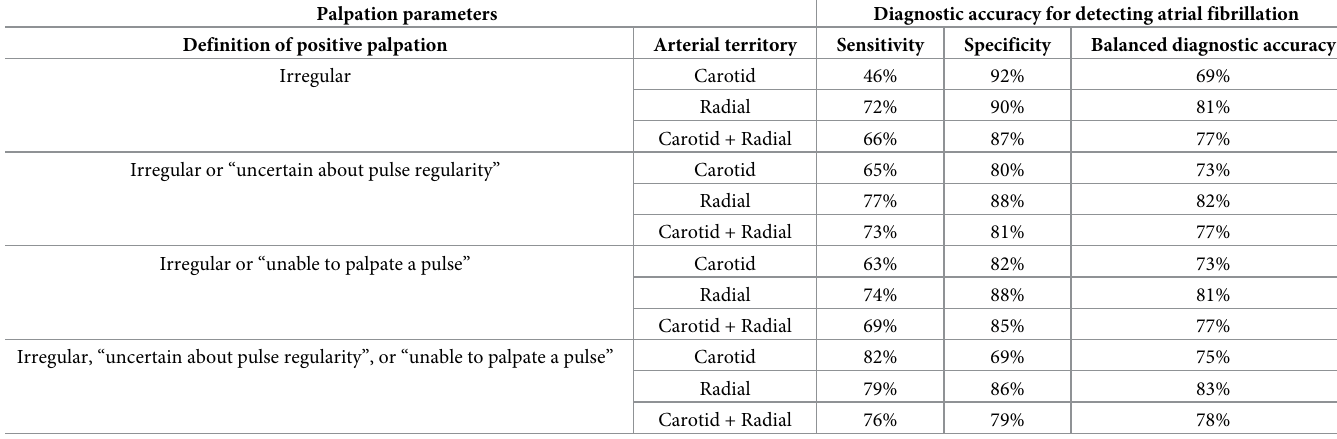
Table 2. Diagnostic accuracy of pulse palpation for detecting atrial fibrillation depending on palpation